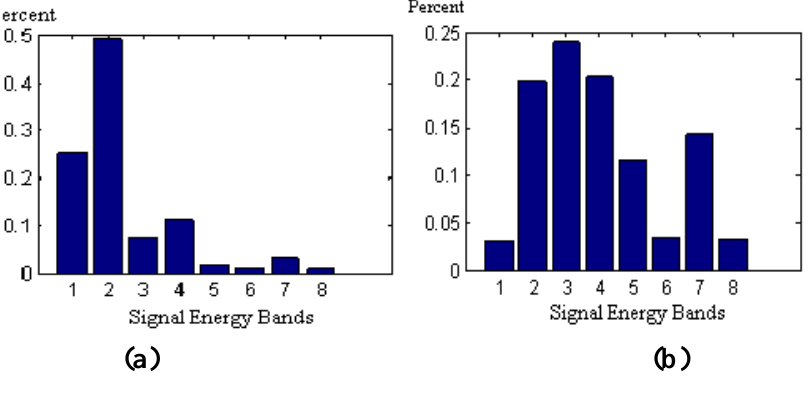
Figure 5. Wavelet energy. (a) normal wavelet energy profile; (b) faulty wavelet energy profile.